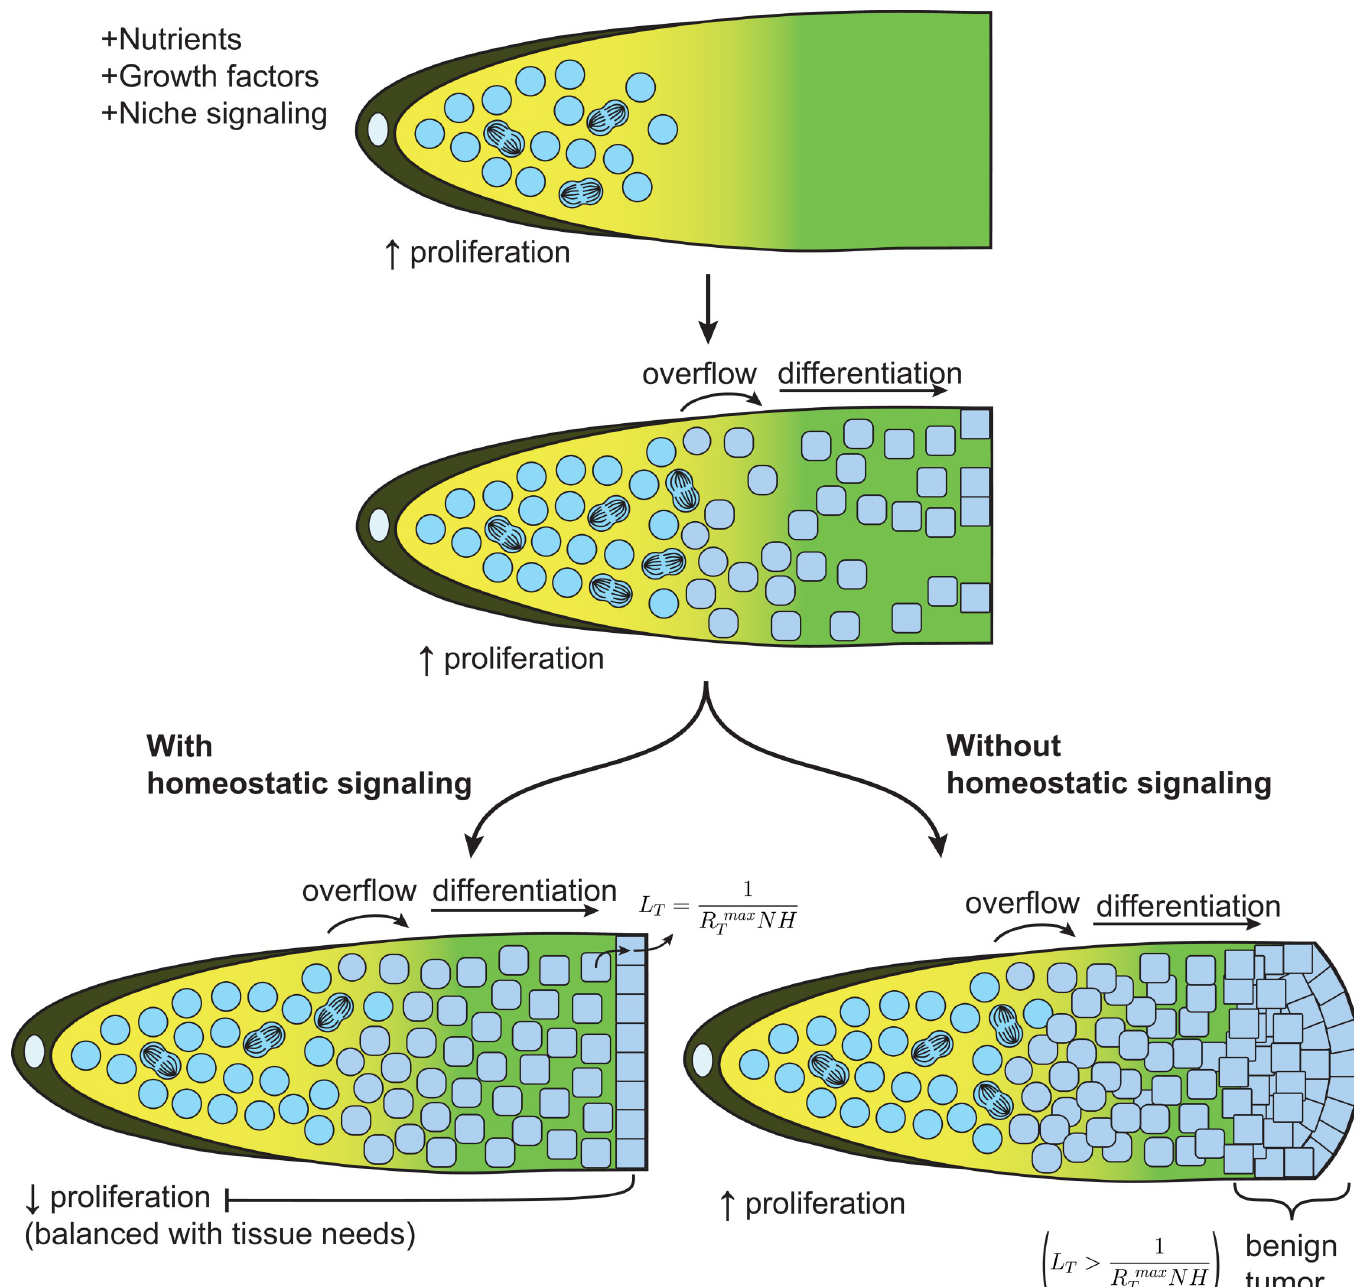
Fig 5. Homeostatic signaling prevents formation of differentiated benign tumors. Top, SCs exposed to niche signaling, growth factors and nutrients, will proliferate to expand in numbers. Middle, Once the niche is filled, SCs begin to overflow outside of the niche and differentiate. Bottom left, Once the tissue has enough terminal cells, homeostatic signaling tunes down SC proliferation. Bottom right, In the absence of homeostatic signaling, SC proliferation always continues at full capacity, causing the formation of a differentiated benign tumor. SC, stem cell.